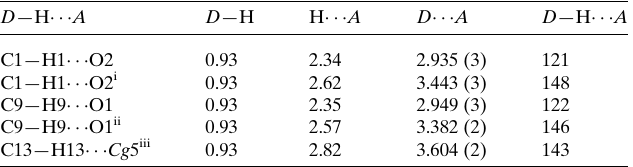
Table 1 Hydrogen-bond geometry (A˚ , (cid:2) ).